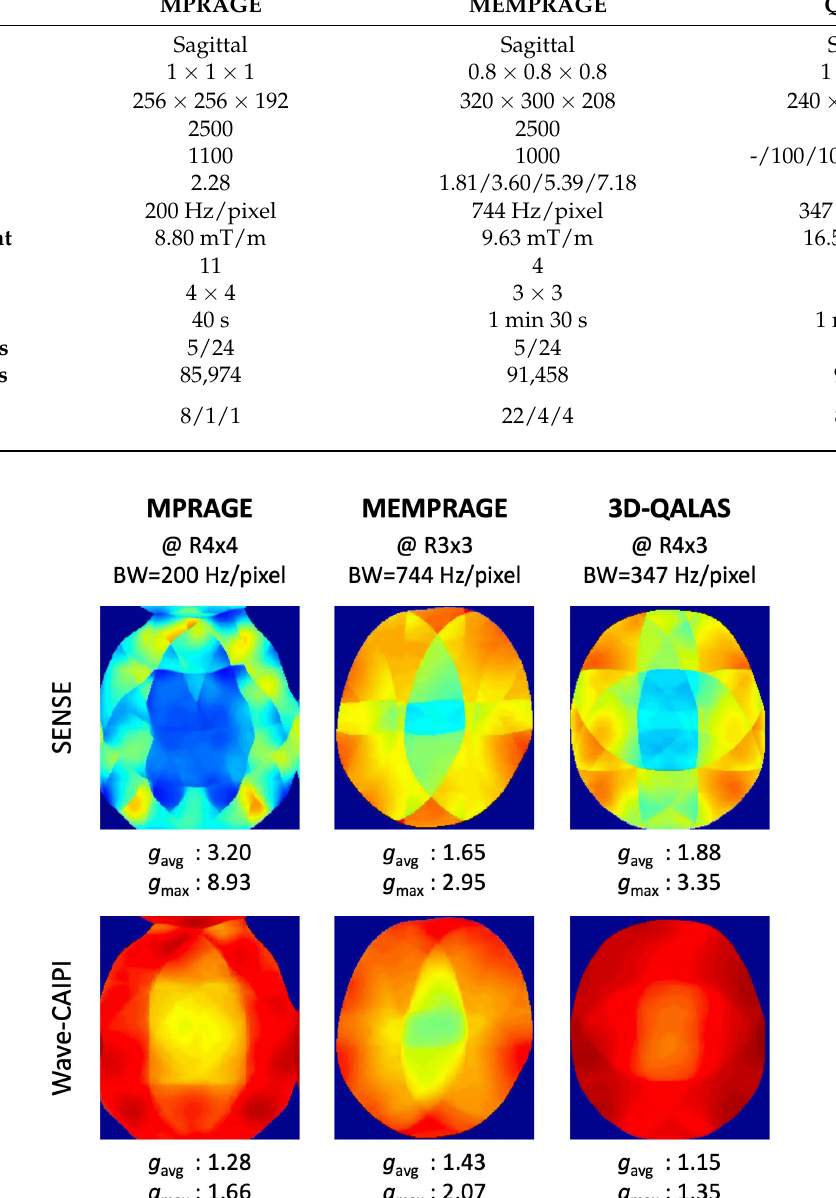
Figure 2. g -factor analyses of SENSE and wave-CAIPI at the target